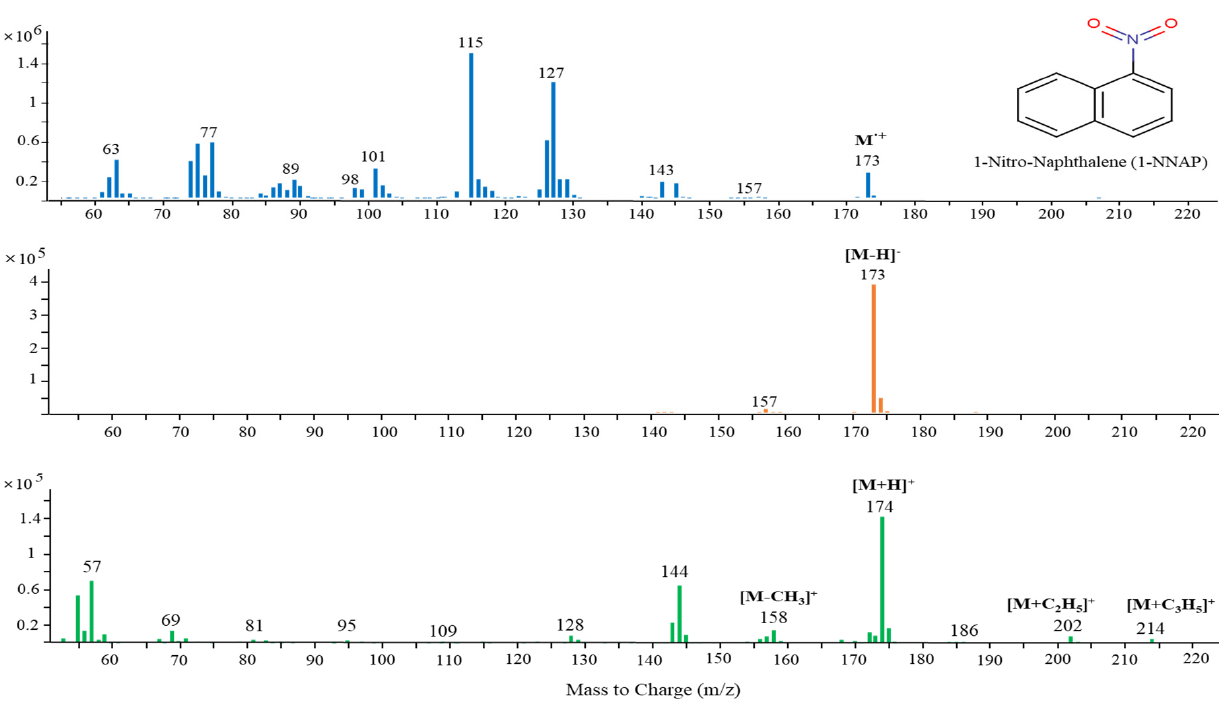
Figure 1. Mass spectra of 1 − nitronaphthalene obtained from each ionization mode: ( a ) EI; ( b ) NCI; ( c ) PCI.